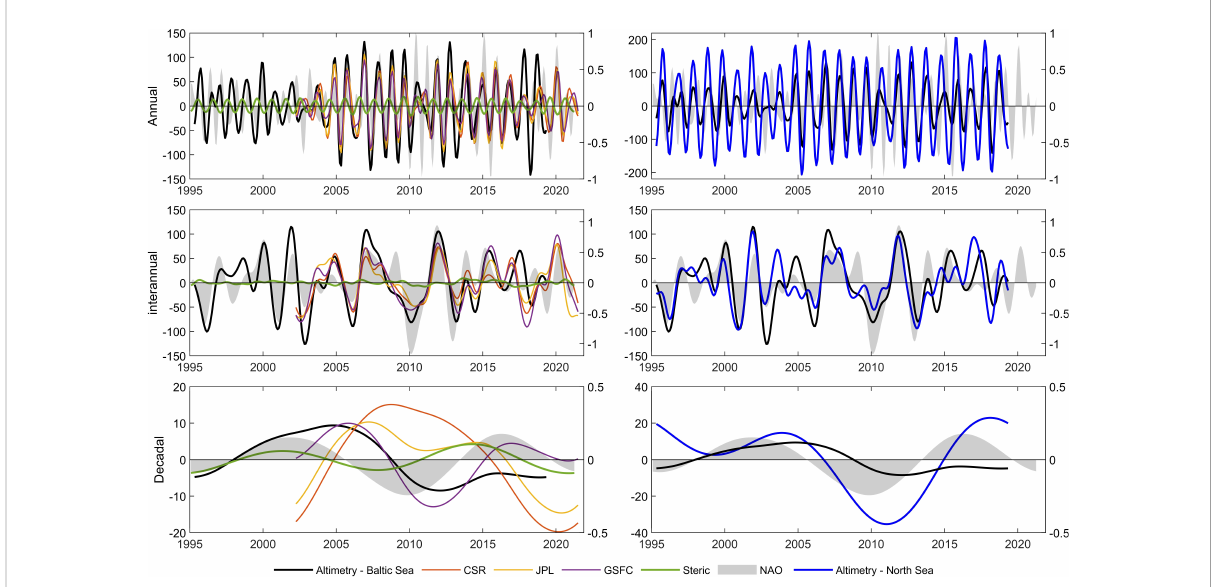
FIGURE 2 Left panels: decomposition of total (altimetry), barystatic (CSR, JPL, and GSFC), and steric sea level in the Baltic Sea on different time scales. Right panels: comparison of sea level variations in the North Sea, Baltic Sea. The shaded area and right axes represent the NAO. Left axes show sea level variations in